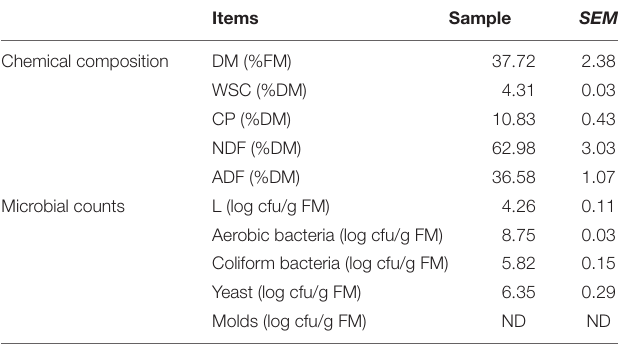
TABLE 1 | Chemical and microbial compositions of fresh native grass. Items Sample SEM